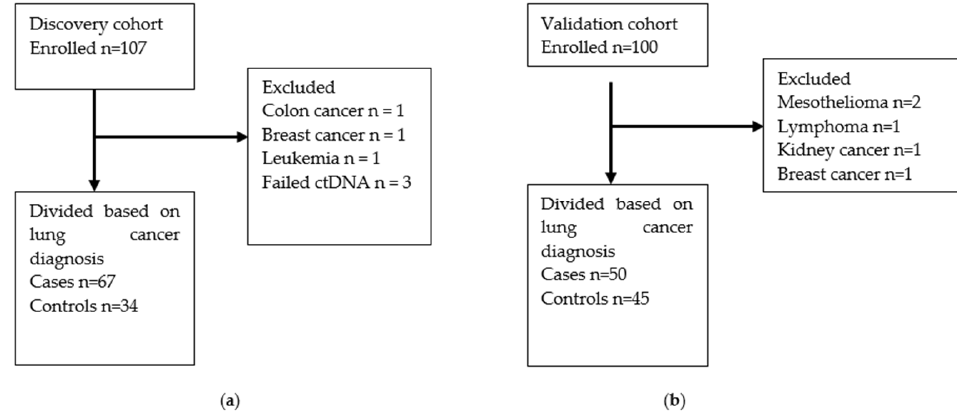
Figure 1. Flow charts illustrating how participants were selected and excluded for ( a ) the Discovery cohort and ( b ) the Validation cohort.